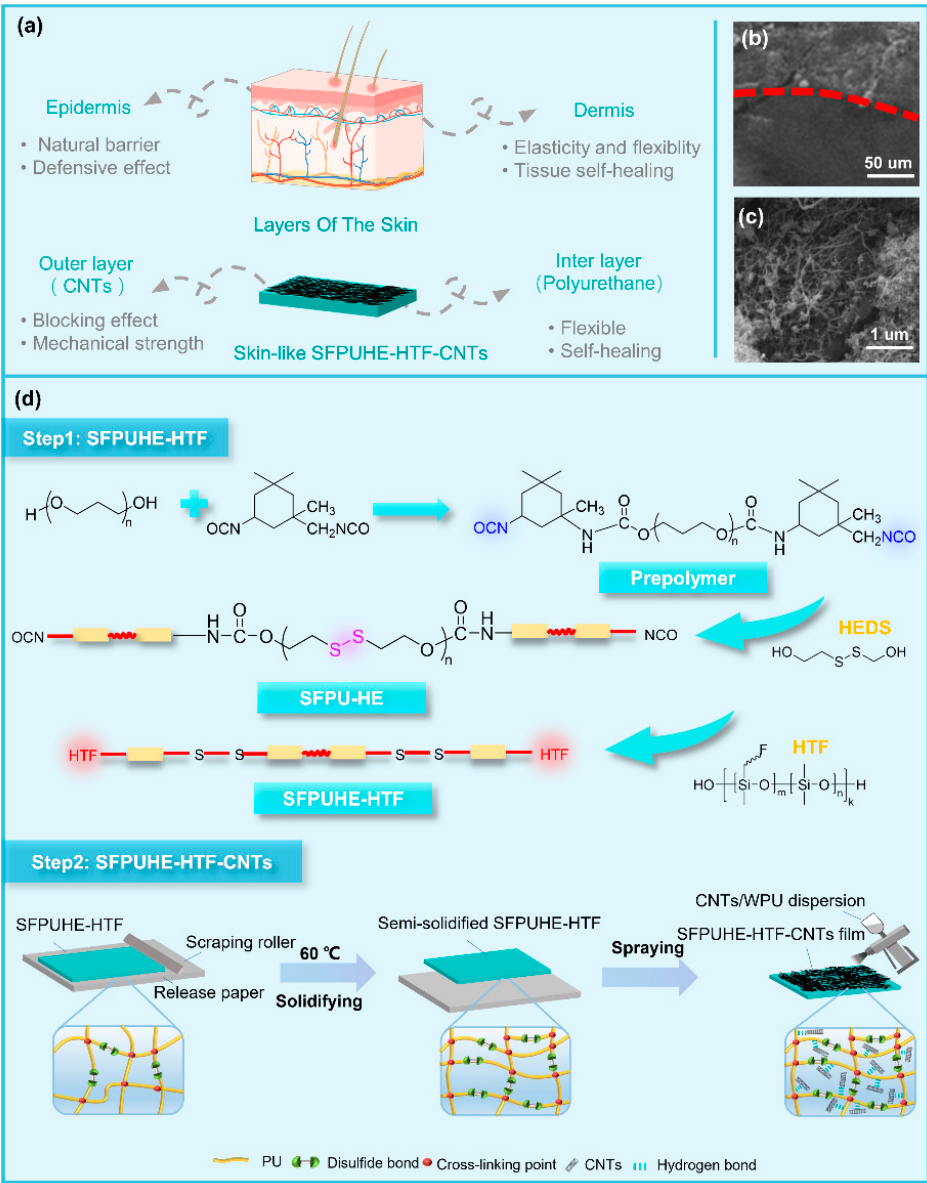
Figure 1. ( a ) Schematic diagram of the design concept for preparing the skin-inspired, bilayer solvent-free polyurethane/carbon nanotubes composites (SFPUHE-HTF-CNTs). The SEM images of ( b ) the bilayer structure and ( c ) the outer CNTs layer. ( d ) The fabrication process of SFPUHE-HTF- CNTs.